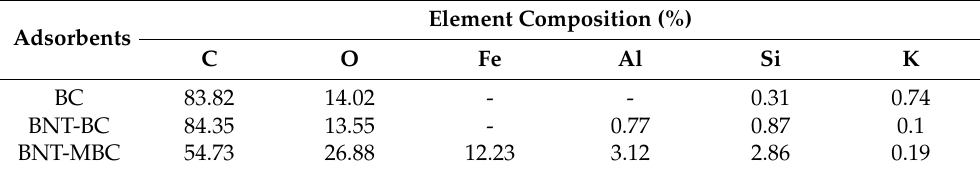
Figure 1. SEM images of BC ( a ), BNT-BC ( b ), and BNT-MBC ( c ). Table 2. Element composition of BC, BNT-BC, and